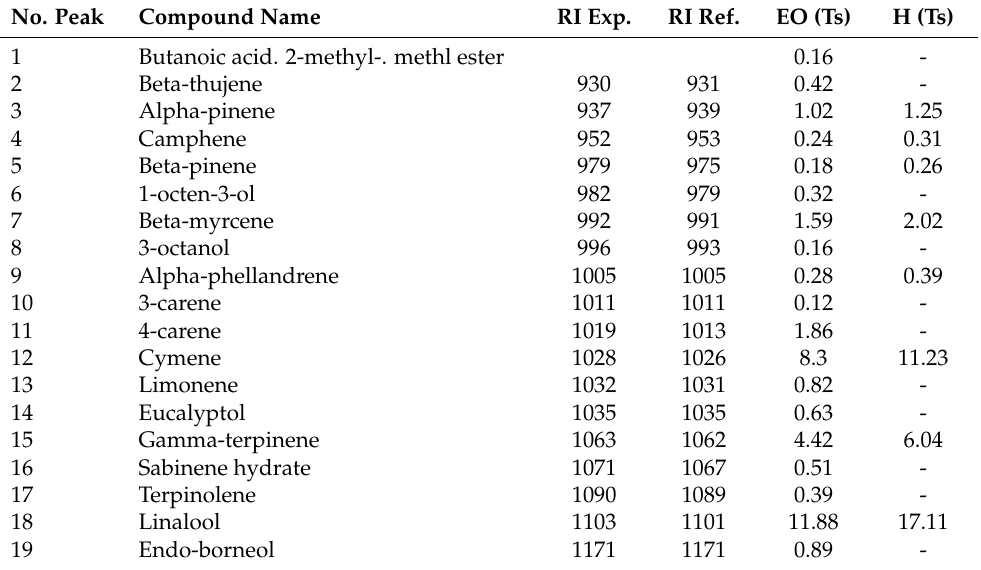
Table 1. Phytochemical composition (%) of essential oil (EO) and hydrolate (H) of Thymus serpyllum (Ts) used in this study, via GC-MS. RI exp: retention index calculated with our experimental results; RI ref: retention index found in the literature for the same compound (source: